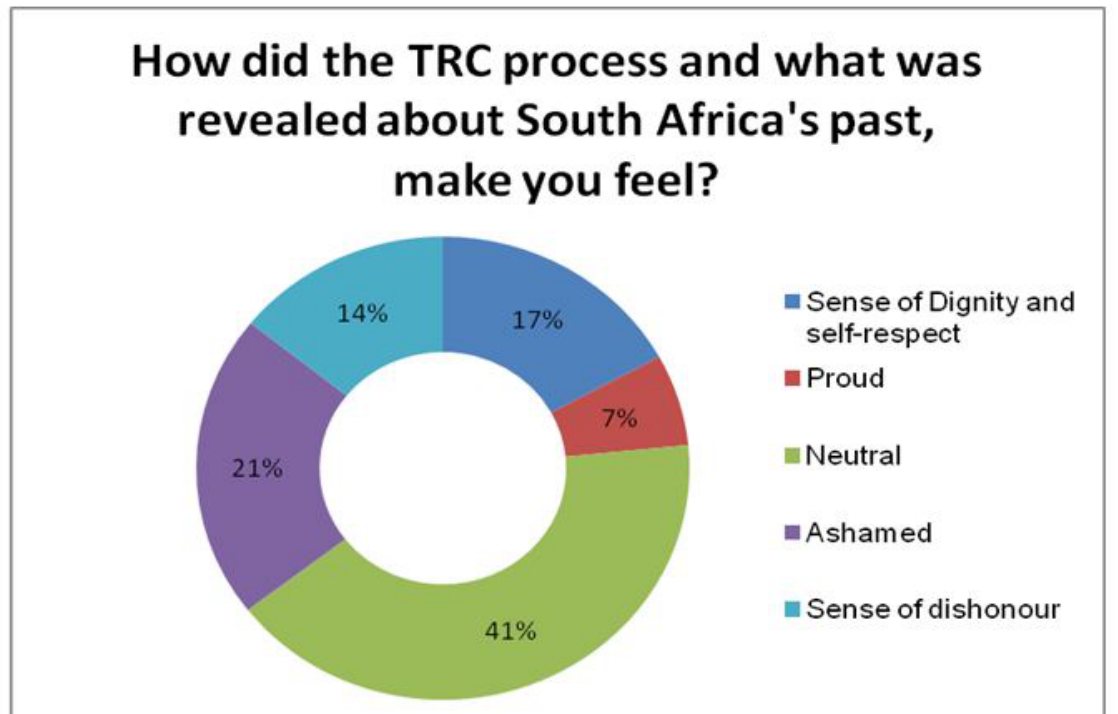
Figure 1: Students’ opinions about the TRC process and what was revealed about South Africa's